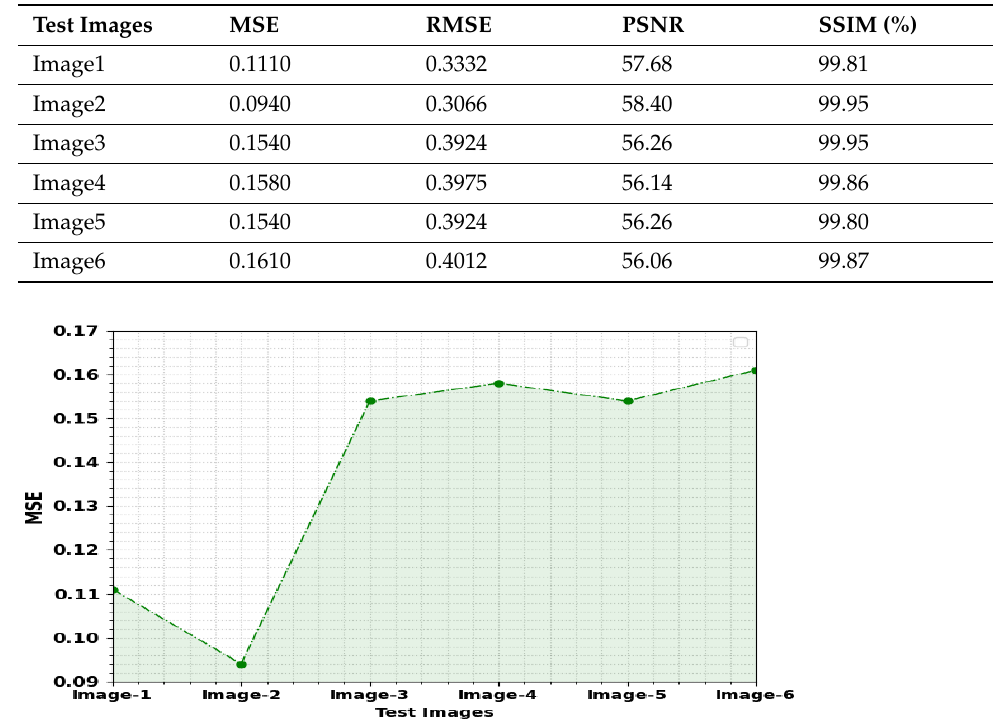
Table 2 and Figure 4 report the outcomes of the PPIE-ODLASC approach on image encryption process. The outcome stated that the PPIE-ODLASC approach has encrypted the images proficiently. For instance, on image1, the PPIE-ODLASC system has obtained an MSE of 0.1110, RMSE of 0.3332, PSNR of 57.68 dB, and SSIM of 99.81%. Meanwhile, in image3, the PPIE-ODLASC method has reached an MSE of 0.1540, RMSE of 0.3924, PSNR of 56.26 dB, and SSIM of 99.95%. Eventually, on image6, the PPIE-ODLASC technique gained an MSE of 0.1610, RMSE of 0.4012, PSNR of 56.06 dB, and SSIM of 99.87%. Table 2. Result analysis of the PPIE-ODLASC system with various images.